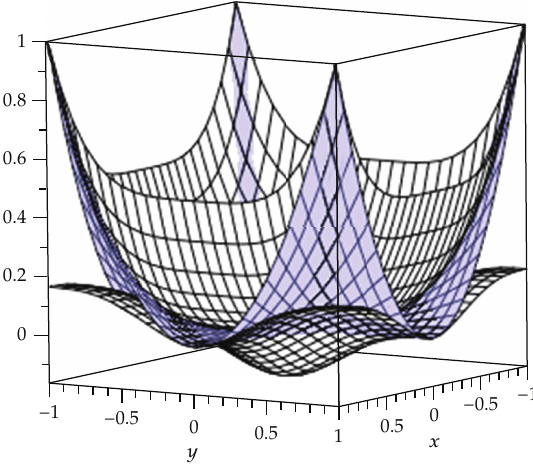
(cid:3) x,y (cid:4) and h ∗ f